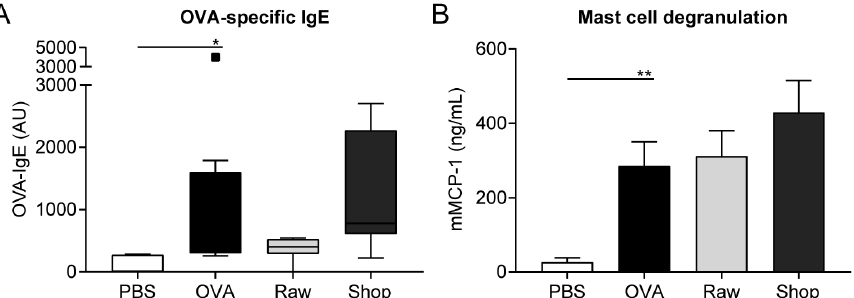
Figure 3. Raw milk treatment did not a ff ect ovalbumin (OVA)-specific IgE levels and mouse mast cell protease-1 (mMCP-1) concentrations. ( A ) OVA-specific IgE levels and ( B ) mMCP-1 concentrations measured in serum 16 h after intragastric challenge. Data are expressed as box-and-whisker Tukey plot (in which outliers are shown as separately plotted points) for OVA-specific IgE levels and as mean ± standard error of the mean for mMCP-1 concentrations, n = 6 in PBS group and n = 8 in all other groups. * p < 0.05, ** p < 0.01 as analyzed with Kruskal–Wallis test for non-parametric data followed by Dunn’s multiple comparisons test for pre-selected groups ( A ) or one-way ANOVA followed by Bonferroni’s multiple comparisons test for pre-selected groups ( B ). PBS, phosphate-bu ff ered saline; OVA, ovalbumin; AU, arbitrary units; raw, raw cow’s milk; shop, shop milk; mMCP-1; mucosal mast cell